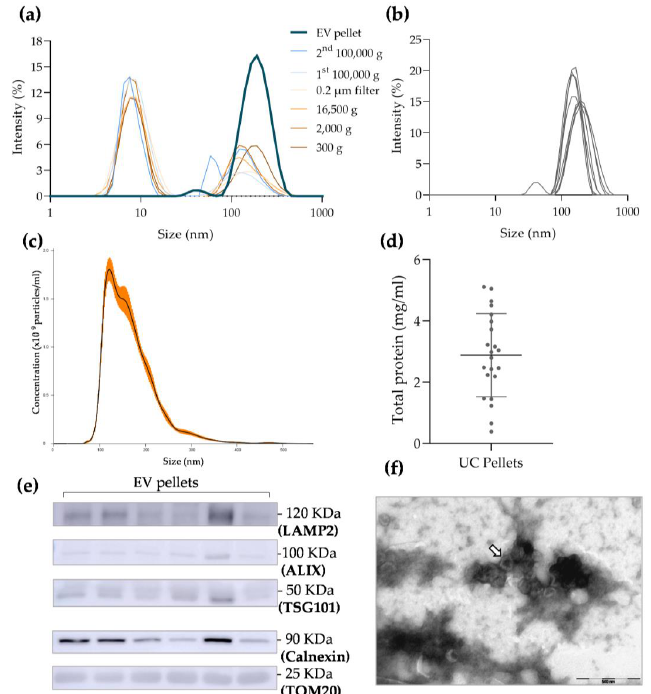
Figure 2. Characterization of extracellular vesicle (EV) samples isolated using ultracentrifugation (UC): ( a ) dynamic light scattering (DLS) analysis of particle size distribution in each supernatant of differential centrifugation protocol and EV final pellet; ( b ) DLS analysis of particle size distribution in follicular fluid (FF)-derived UC pellets ( n = 9); ( c ) nanoparticle tracking analysis (NTA) of particle concentration and size distribution in FF-derived UC pellets ( n = 3; orange bars indicate ± SEM); ( d ) total protein quantification of each EV pellet using microBCA kit ( n = 22); ( e ) Western blot membrane showing the expression of specific EV positive markers, such as LAMP2, ALIX, and TSG101, and also the presence of cellular contaminants in the final UC pellet, such as Calnexin and TOM20 ( n = 6; see Supplementary materials for controls); ( f ) representative image of EVs isolated using UC obtained with transmission electron microscopy observations (EV cup-like structure indicated by the arrow).